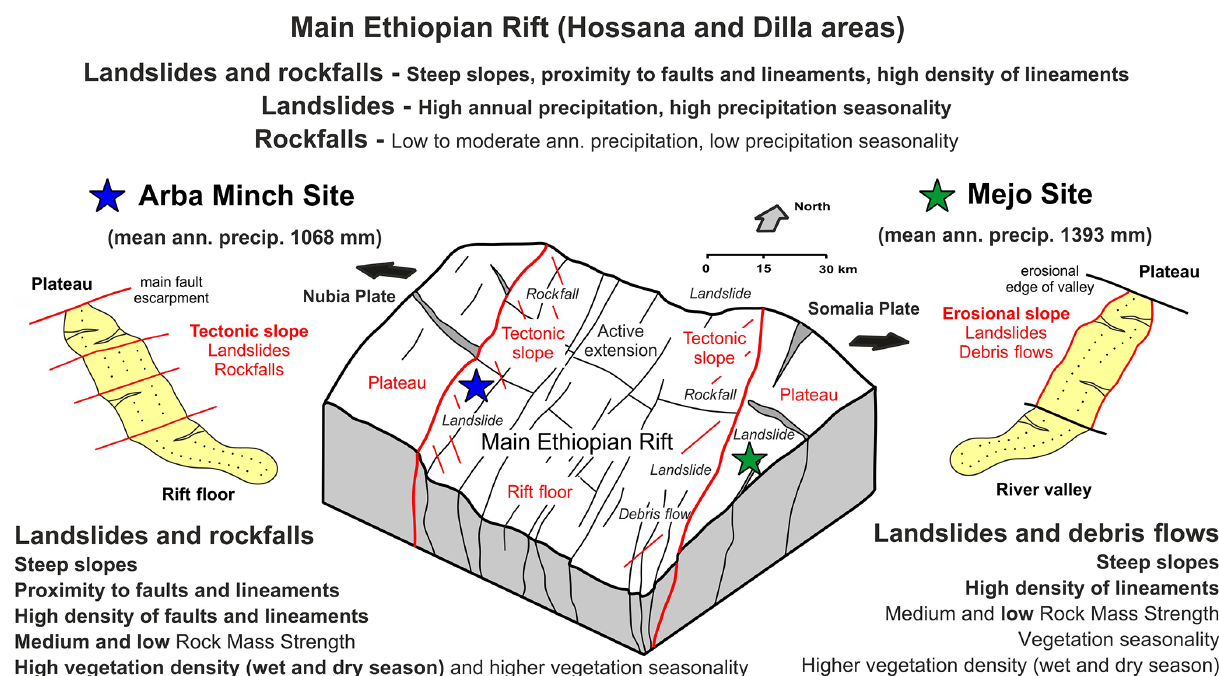
Figure 12. Sketch diagram summarizing the main factors controlling the formation and distribution of particular slope failures in the MER and in the Arba Minch and Mejo study